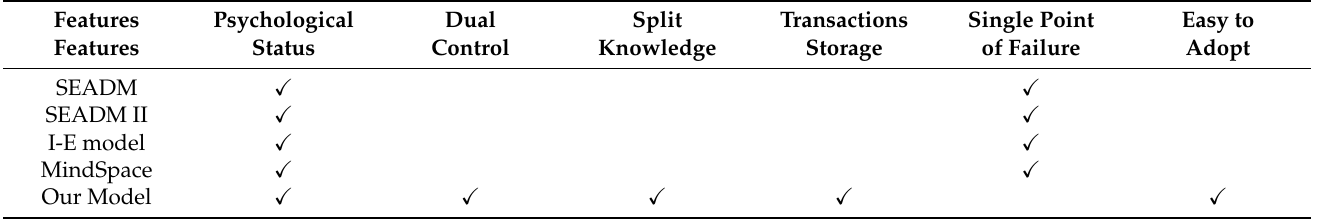
Table 2. Proposed model features and ability to implement security principles: comparison with other